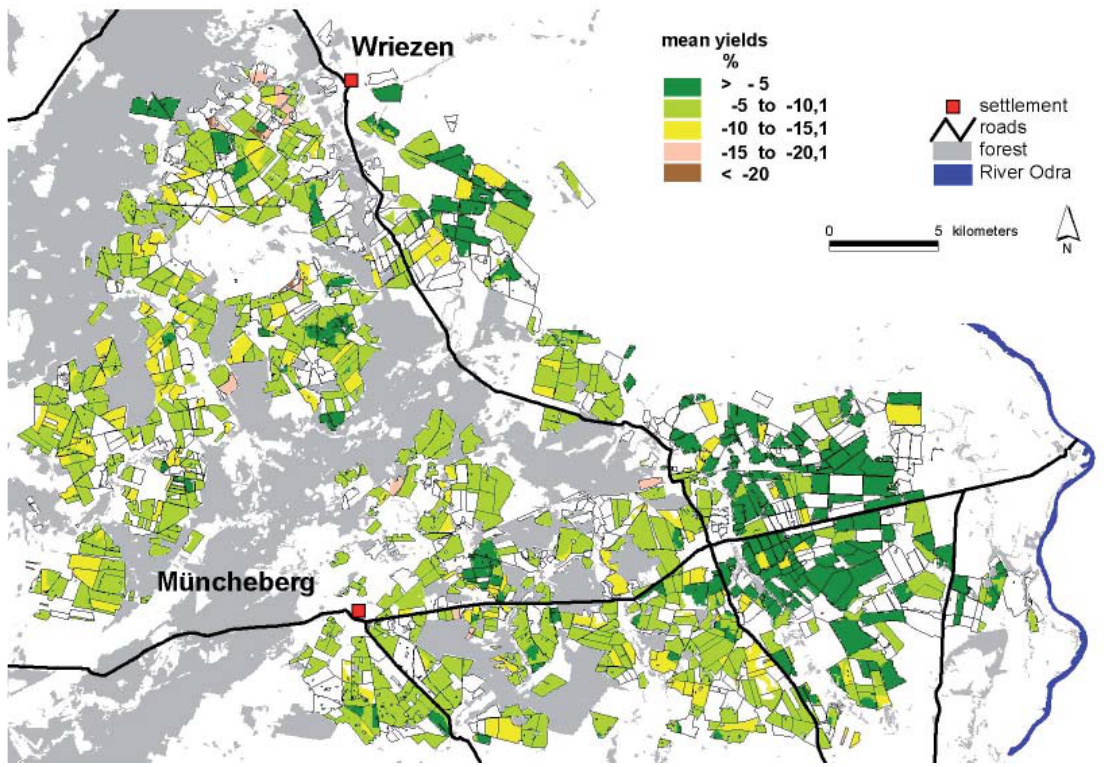
Figure 12. Difference between mean yields of Scenario 2050 and Initial Situation 2000 (excluding the effect of increased atmospheric CO 2